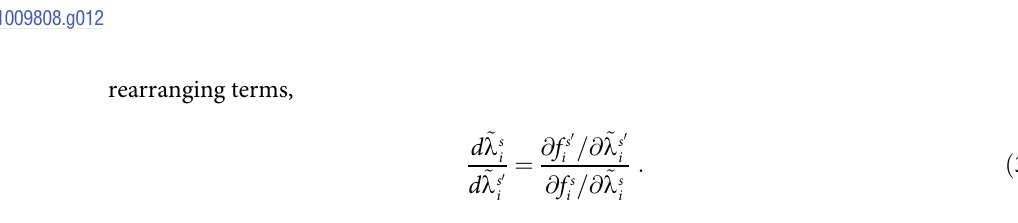
Fig 12. Dynamics for different numbers of glomeruli, M , and granule cells, N (specified at the top of each column), are qualitatively similar. (A) Mitral cells. The activity of one mitral cell is highlighted with a dark trace; the remaining sisters are overlayed with a light trace. (B) Granule cells. Granule cells representing molecules present in the true odour are coloured green and the 10 most active granule cells representing molecules not present in the true odour are coloured gray. Granule cell dynamics are all qualitatively similar and converge to the MAP solution (red triangles). (C) RMS error between the granule cell activity and the MAP estimate for 5 random systems of the same size as in the previous rows (gray) and the average (green). All systems converge with similar dynamics to the MAP estimate. Remaining parameters are from Table 1, except S =